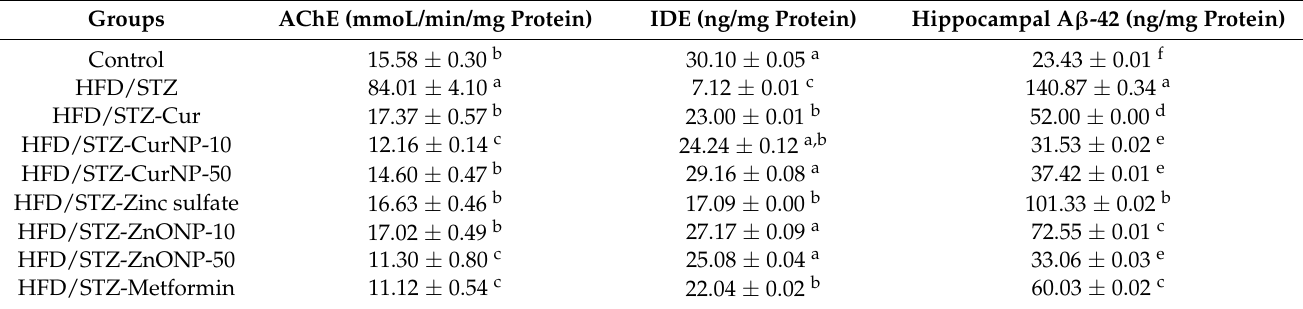
Table 4. Regulation of A β -42 clearance, levels of IDE, and activity of AChE in the hippocampus of HFD/STZ-induced rats after treatment with CurNP and